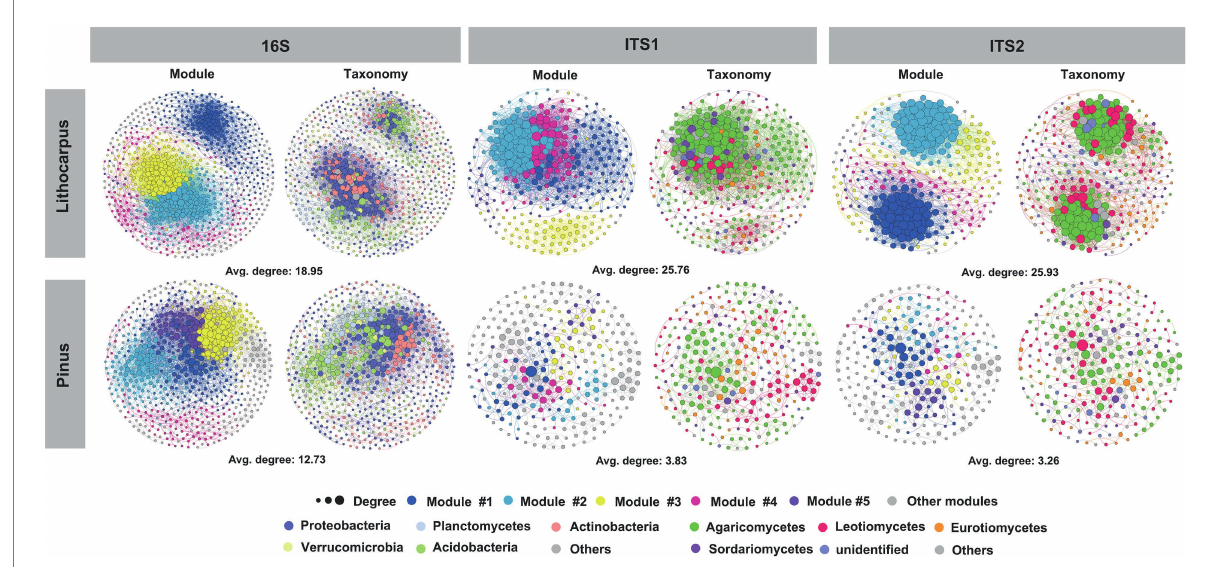
FIGURE 2 The co-occurrence networks of bacterial and fungal OTUs in Lithocarpus and Pinus ECM roots. The nodes in the network are colored based on phylum and class level or modularity class. The edge thickness is proportional to the weight of each correlation and node size is proportional to the degree of each OTUs. The co-occurrence network analysis based on ITS1 sequences have been carried out using samples collected during the wet season